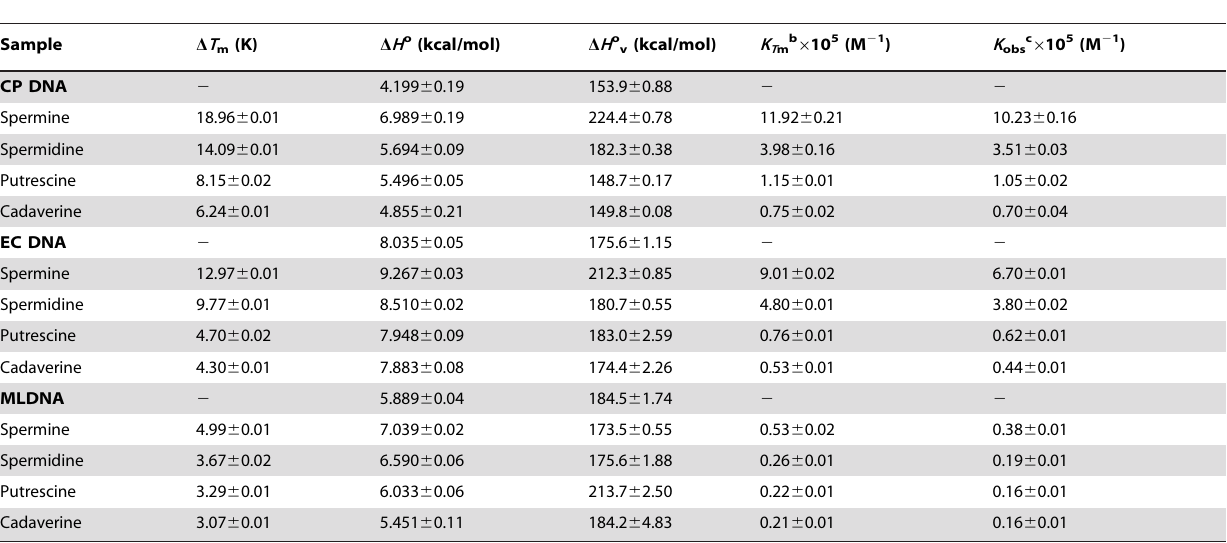
Table 5. Thermal melting data and the binding constants from melting data at saturating concentrations of polyamines with CP DNA, EC DNA and ML DNA a